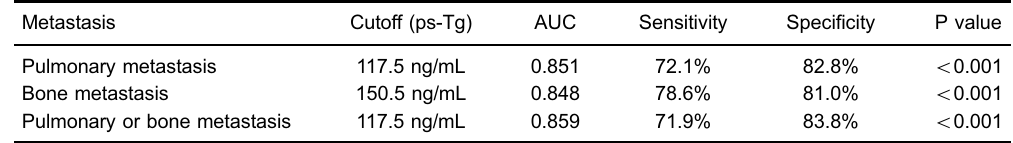
Figure 4. Analysis of patients over 18 years. ROC of serum postoperative stimulated thyroglobulin (ps-Tg). ROC in identifying the presence of A , pulmonary metastasis; B , bone metastasis; and C , either pulmonary or bone metastasis. The area under the curve (AUC) was 0.851 (pulmonary), 0.848 (bone), and 0.859 (pulmonary or bone). Table 5. Ps-Tg values to identify distant metastases in patients with differentiated thyroid cancer over 18 years.